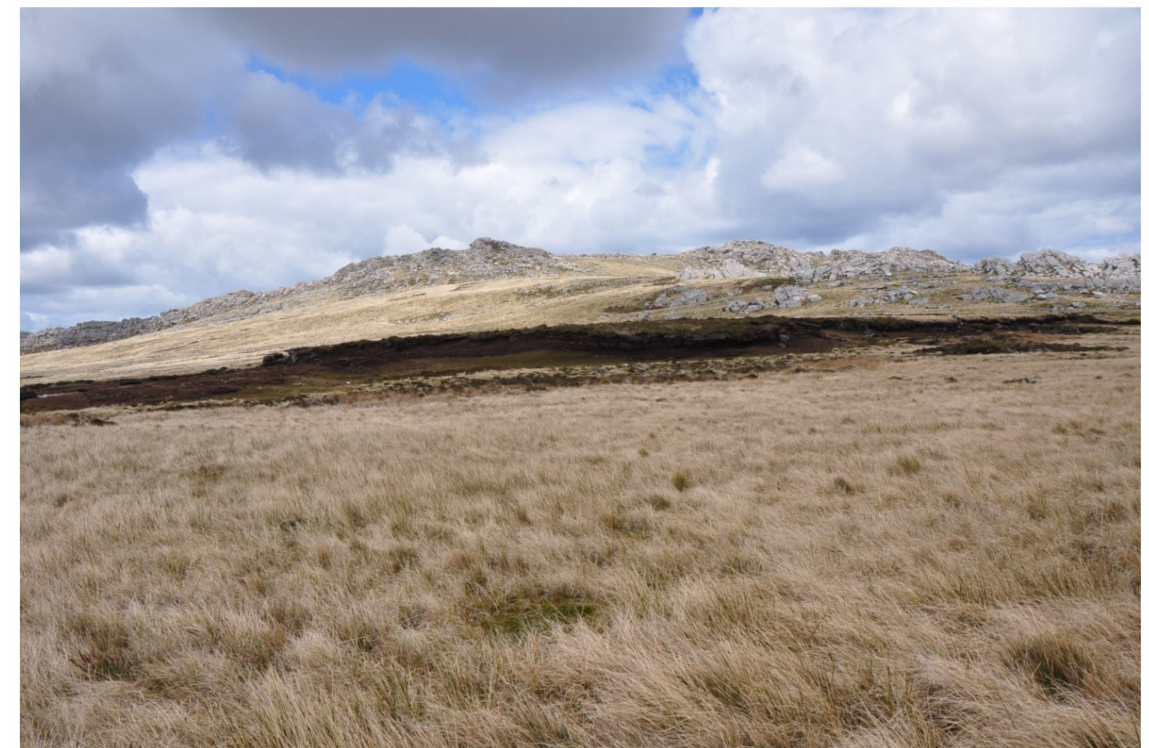
Figure 12. View of Falkland Island peat bank (bog) between Mt Harriet and Goat Ridge. Source: Edward Maltby.